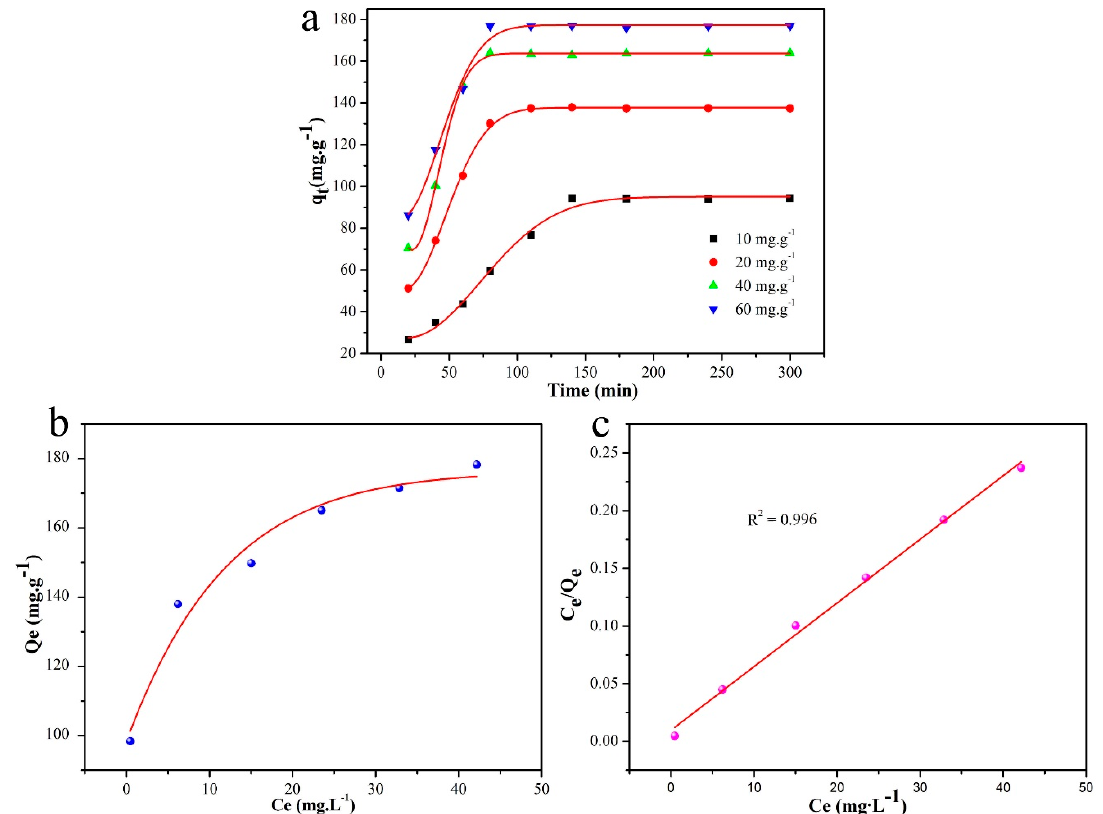
Figure 7. ( a ) Adsorption curves under different concentrations of MB; ( b ) adsorption isotherm of an MB solution in MnO-4; ( c ) Langmuir isotherm plot for MB adsorption in MnO-4.